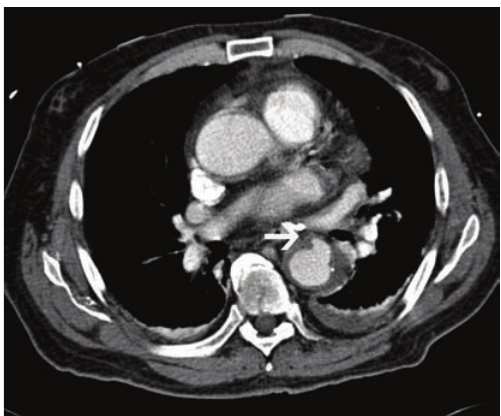
Figure 15: Penetrating atherosclerotic ulcer—axial postcontrast CT scan in a 48-year-old male with acute chest pain shows contrast outpouching from the anterior aspect of descending thoracic aorta (arrow), consistent with a penetrating atherosclerotic